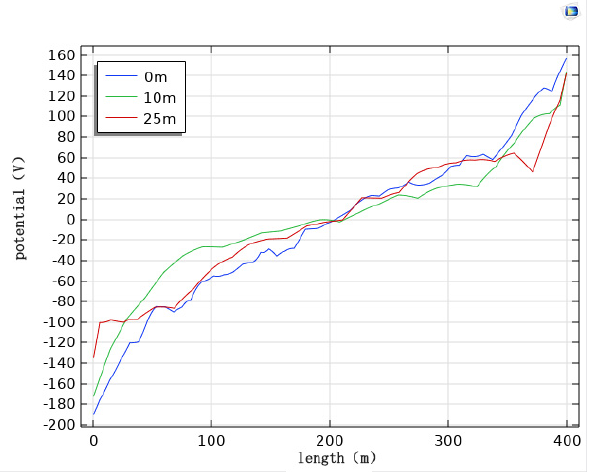
Figure 16. The effect law of parallel distance on the cathodic protection potential of the pipeline.